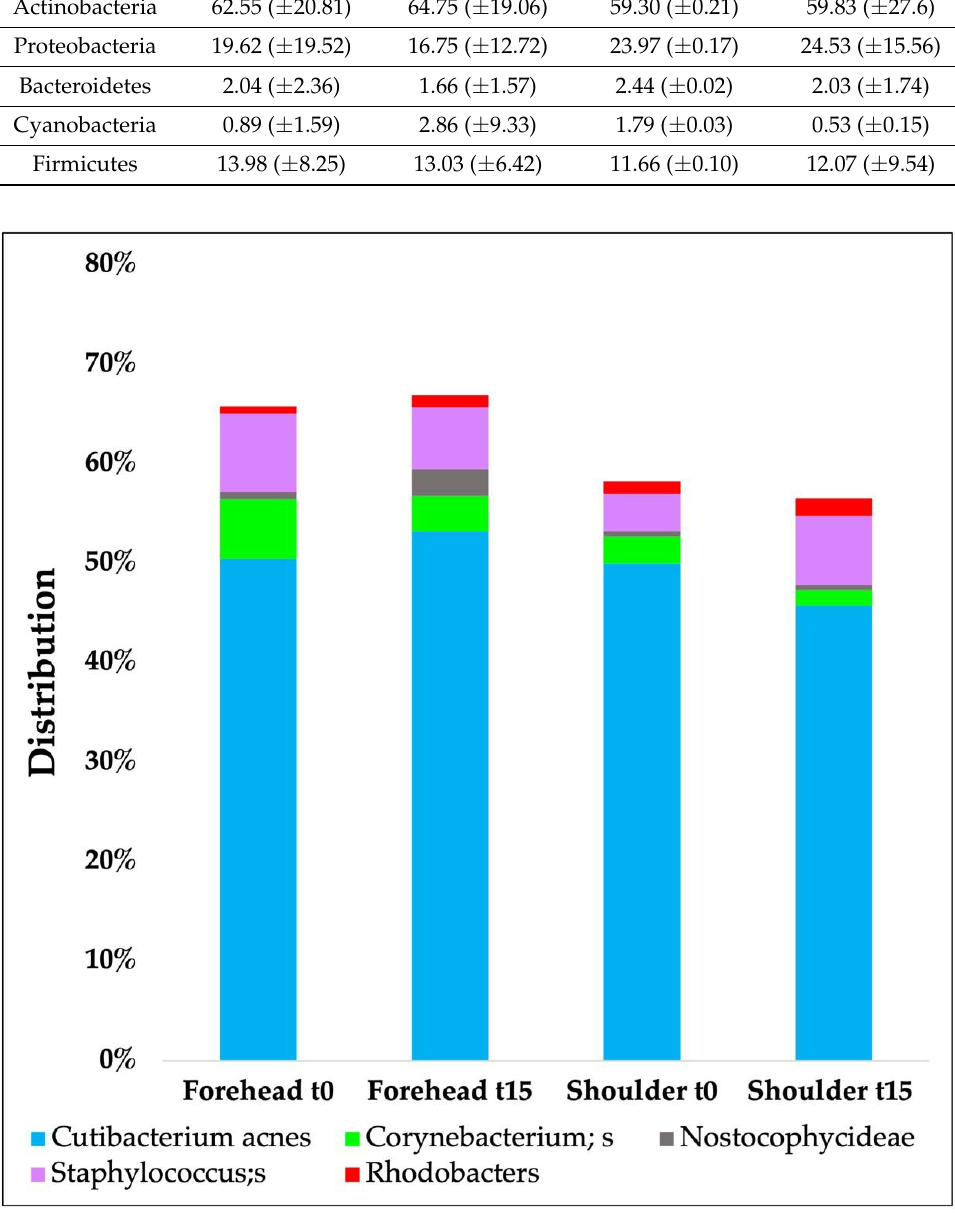
Figure 5. Microbiota analyses results (species level) over time carried out on 20 volunteers.